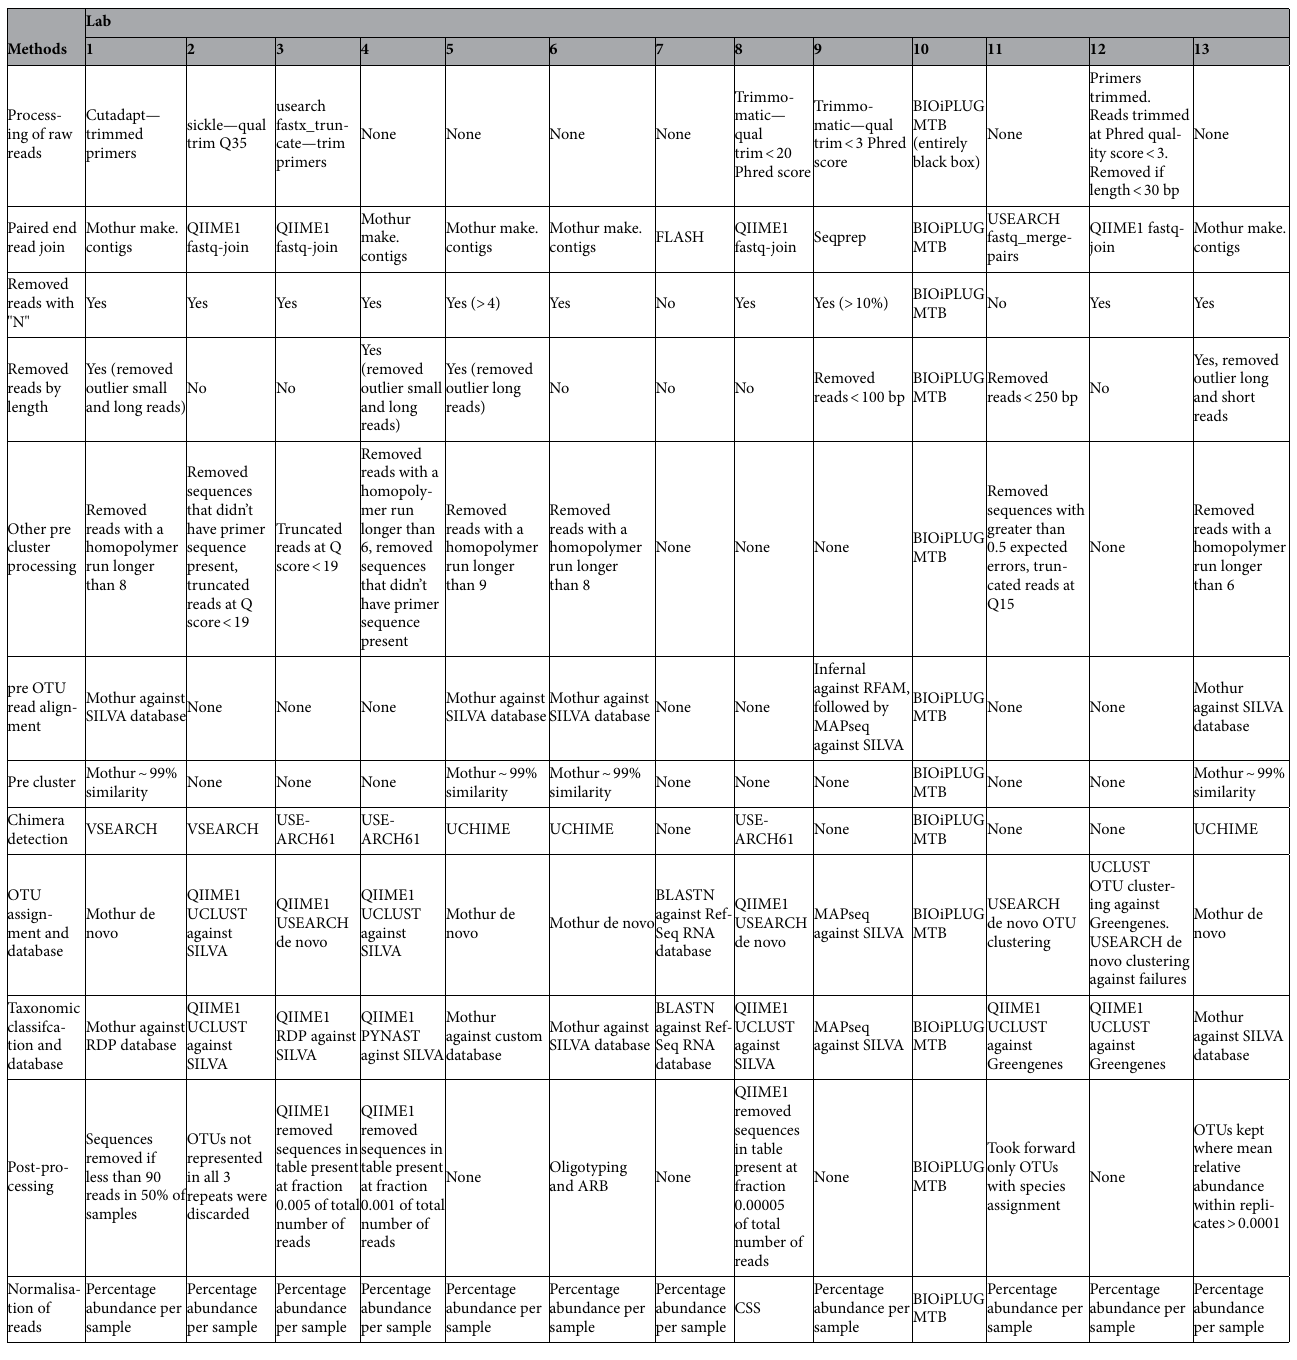
Table 4. Summary of the methods used by the different